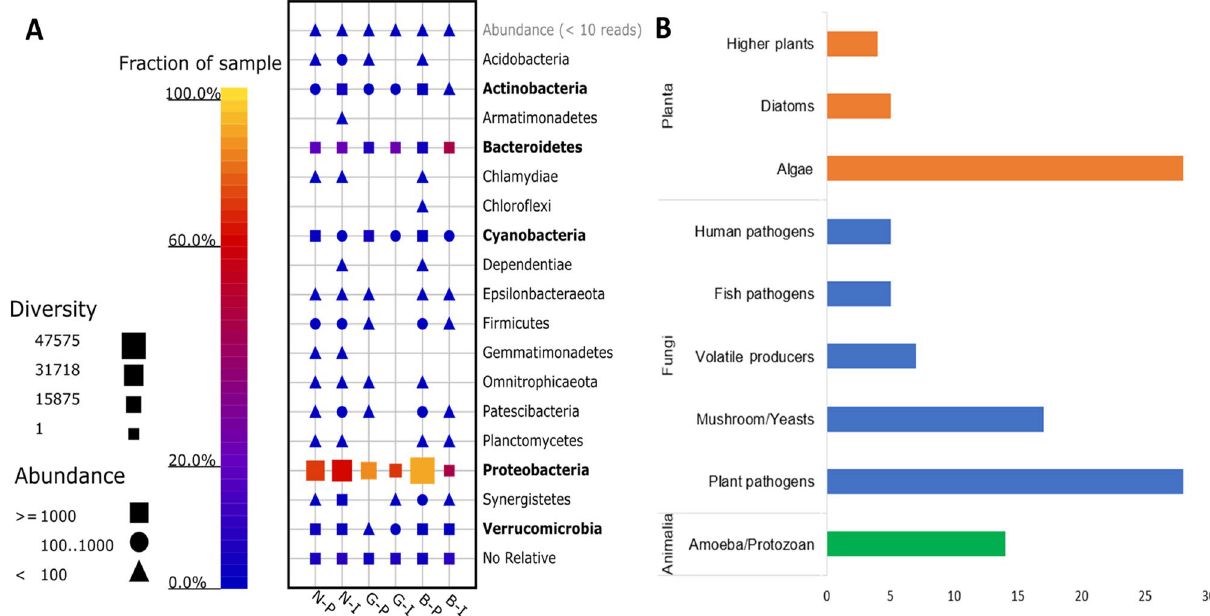
Figure 1. Microbial diversity detected by the metabarcoding analysis. The relative abundance of identified bacterial OTUs among the six water samples, where top abundant bacterial phyla are written in bold ( A ). The histogram plot shows the identified eukaryotic groups per domain (Planta, Fungi, or Animalia). The target group in the eukaryotic metabarcoding analysis was the fungal group distributed according to their prominent role and function (BBMerge–accurate paired shotgun read merging via overlap).